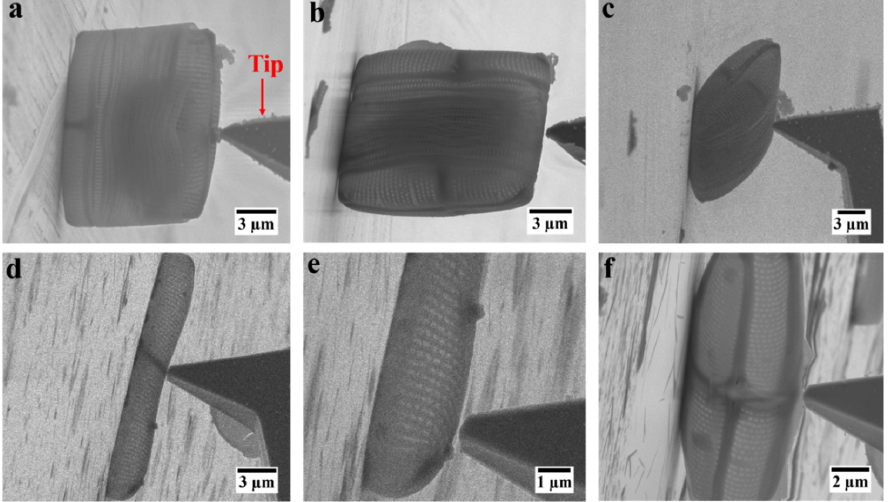
Figure 2. SEM images of different orientations of intact frustule and isolated valves of C. sp. for in situ deformation tests: ( a ) intact frustule standing upright; ( b ) intact frustule standing on girdle bands; ( c ) intact frustule laying on the girdle bands; ( d , e ) deformation test at different locations of an isolated valve laying flat; ( f ) deformation test on isolated valve standing on its side.